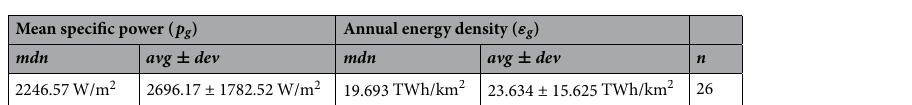
Table 4. Mean and annual power and energy densities for combined-cycle natural gas power plants scatter- plotted in Fig. 2.